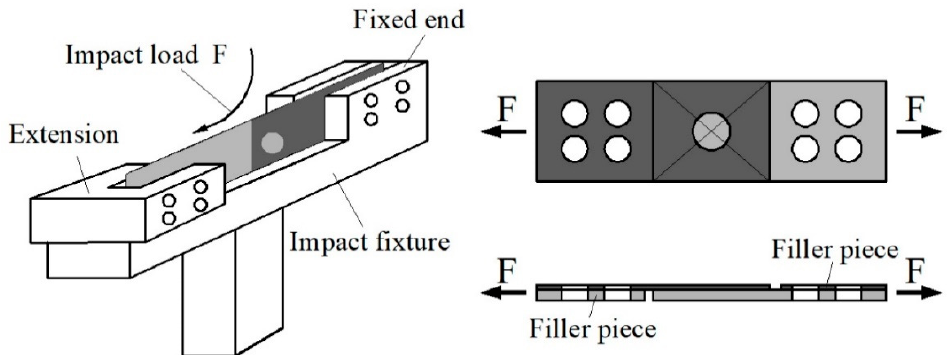
/ steel keyhole-free FSSW